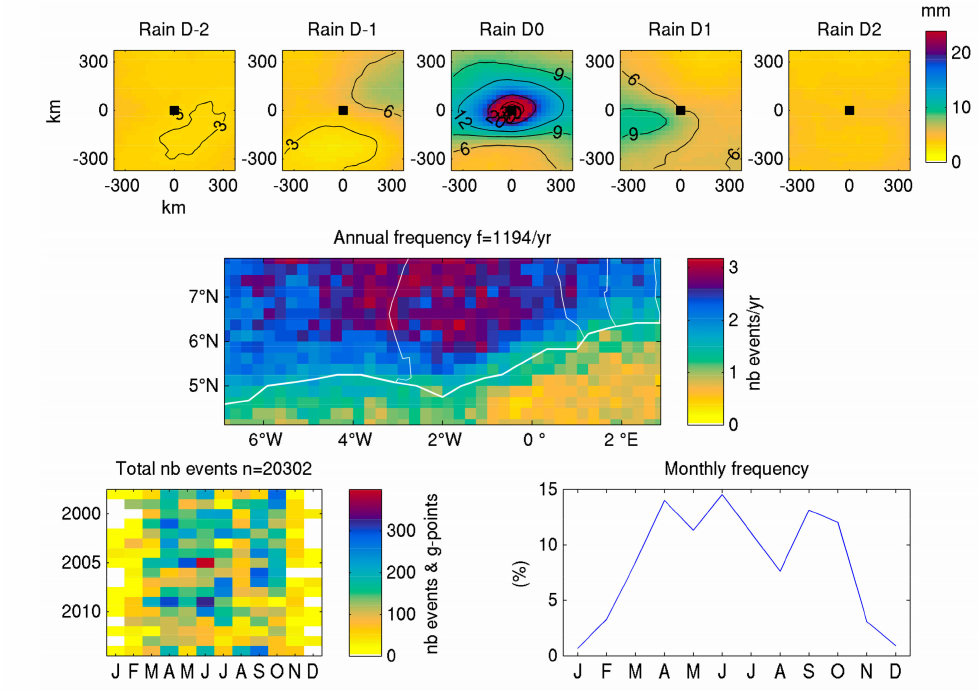
Figure 5. Typing of intense rainfall events: cluster 1. Top panels: spatial rainfall patterns, in relative coordinates (km around the grid-point where the event occurs, denoted by a black square), for each day of the 5-day sequence (2 days before to 2 days after the event). Central panel: geographical distribution of the number of intense events pertaining to the cluster. Bottom panels: seasonal distribution of the events (right) and interannual variations of the number of events